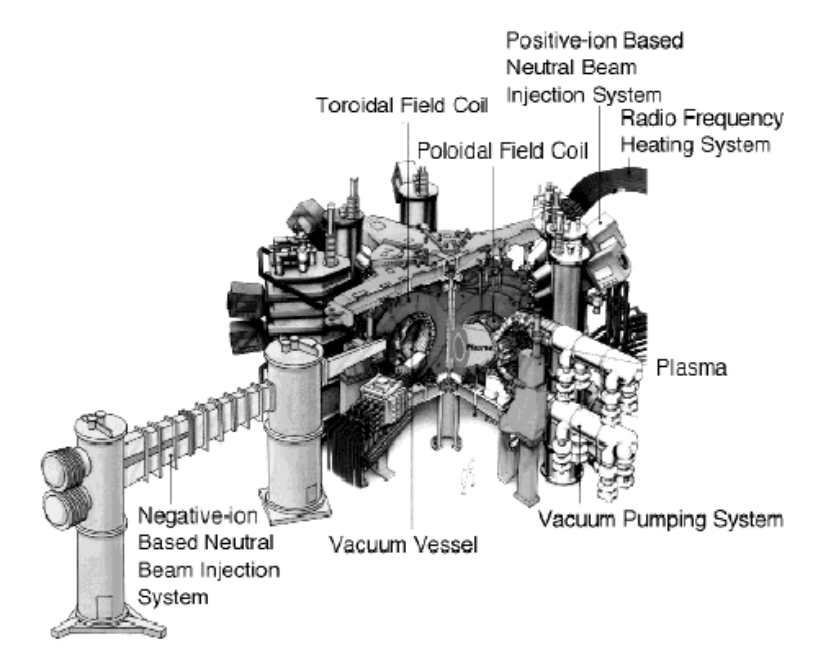
Figure 23. Bird’s eye view of N-NBI injector and JT-60U